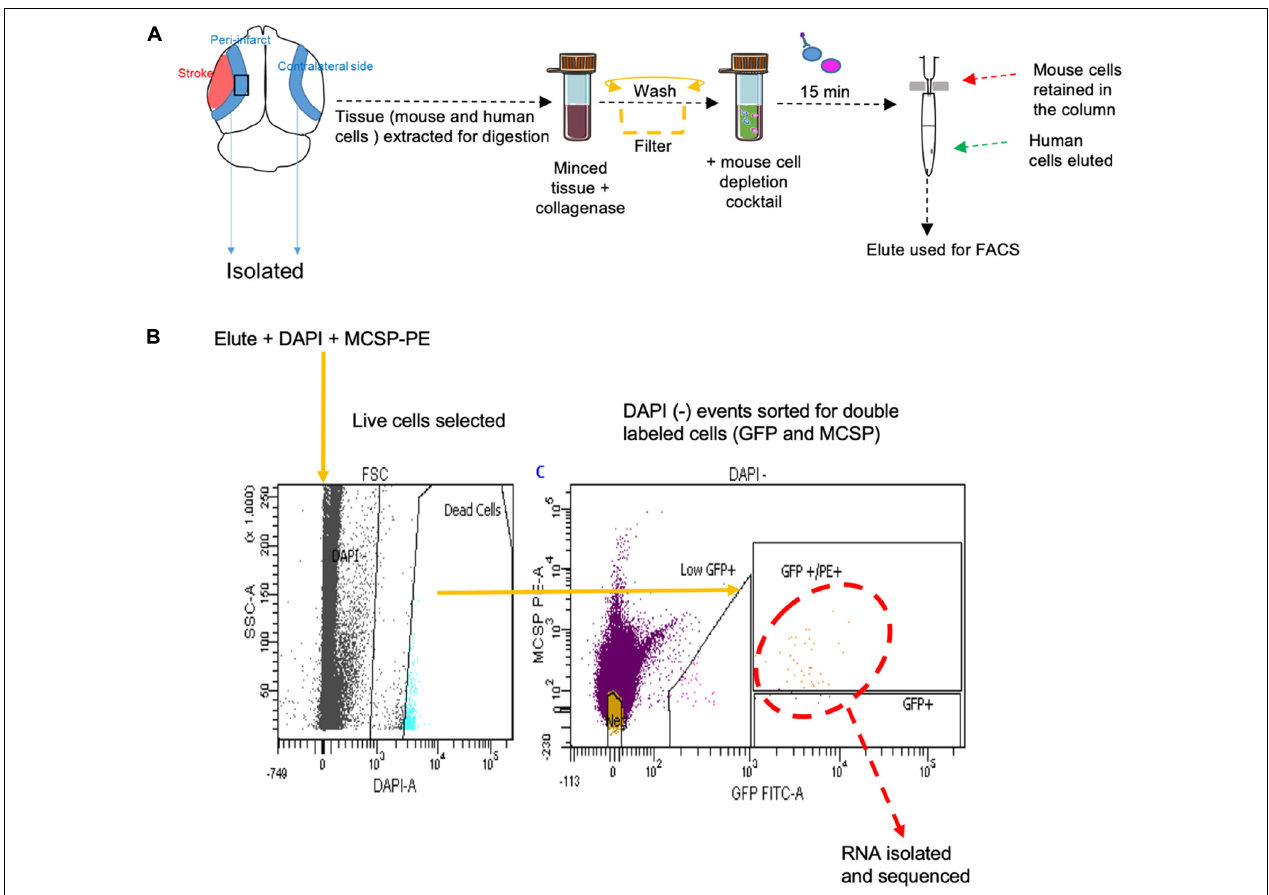
FIGURE 5 | (A) Schematic representation of tissue processing and FACS sort methodology performed. (B) Gating areas used during FACS and the GFP and MCSP-PE double positive cells were isolated for RNA sequencing. MCSP, melanoma-associated chondroitin sulfate proteoglycan.